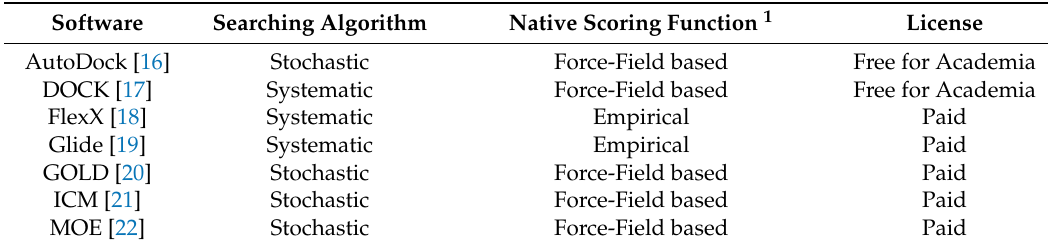
Table 1. Examples of some of the most popular currently available docking software. For a comprehensive list see